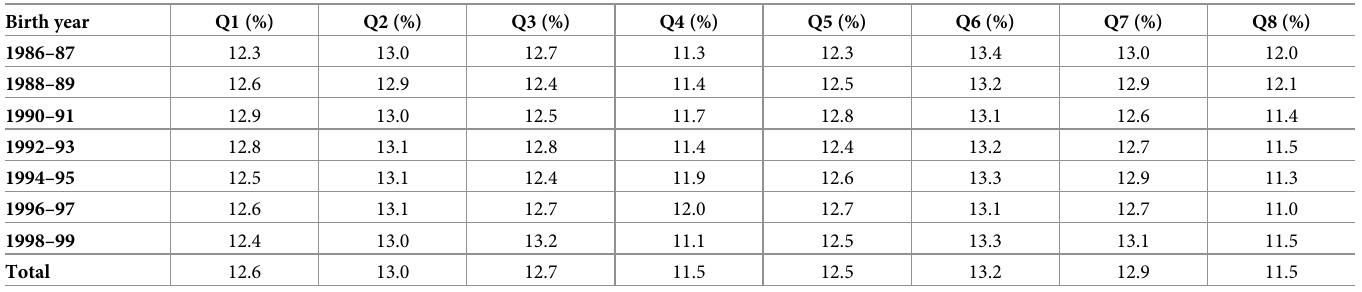
Total Q = quartile.